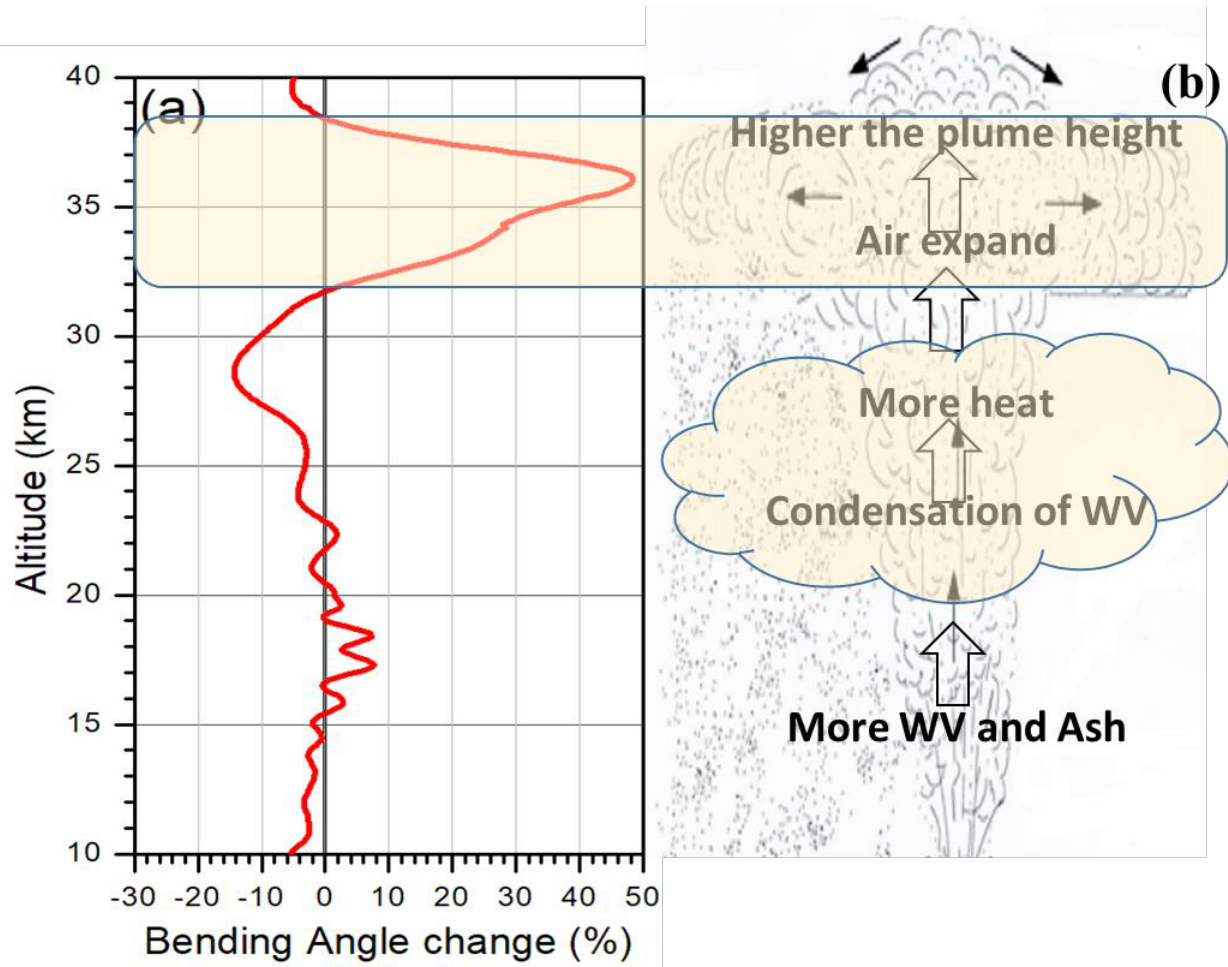
Figure 7. ( a ) observed COSMIC – 2 RO bending angle anomaly at 5:17 UTC on 15 January 2022; ( b ) schematic diagram summarizing the observed extreme heights of the Tonga volcanic plume on 15 January 2022.